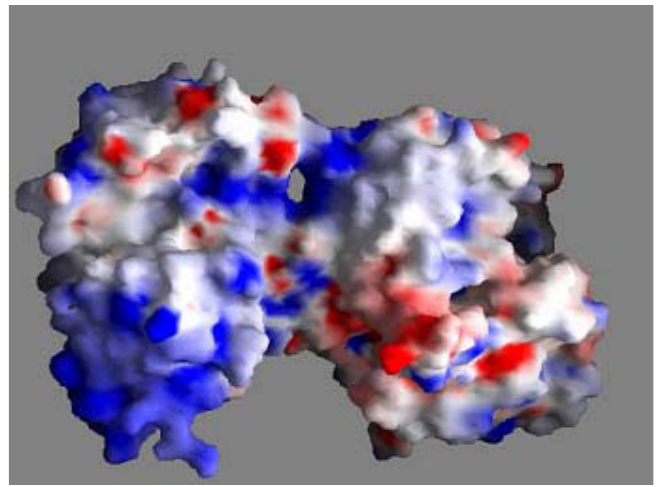
Figure 3. Distribution of surface charge of human lactoferrin. Blue: positive; red: negative. From Baker and Baker